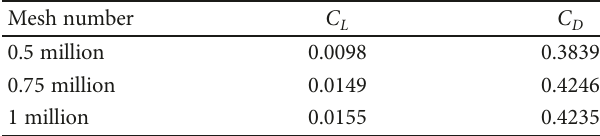
Table 4: Mesh independence